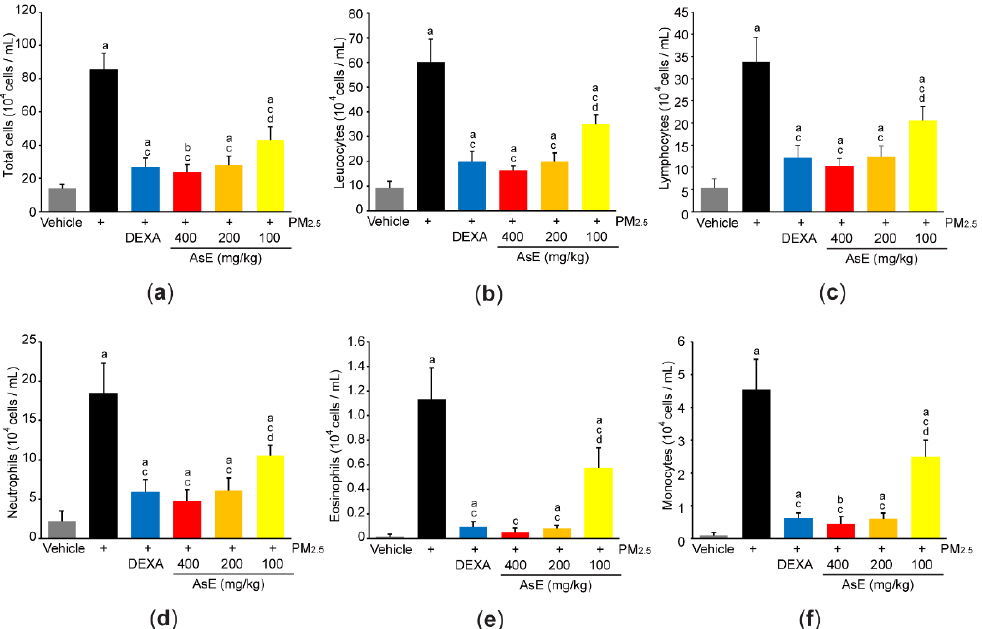
Figure 5. AsE reduces inflammatory cell infiltration in the lungs. ( a – f ) Cytological analysis. Number of total cells ( a ), leukocytes ( b ), lymphocytes ( c ), neutrophils ( d ), eosinophils ( e ), and monocytes ( f ) were counted using BALFs obtained from the upper and middle right lobes. a p < 0.01, b p < 0.05 versus vehicle group; c p < 0.01 versus PM 2.5 group; d p < 0.01 versus PM 2.5 + DEXA group; BALF, bronchoalveolar lavage fluid.